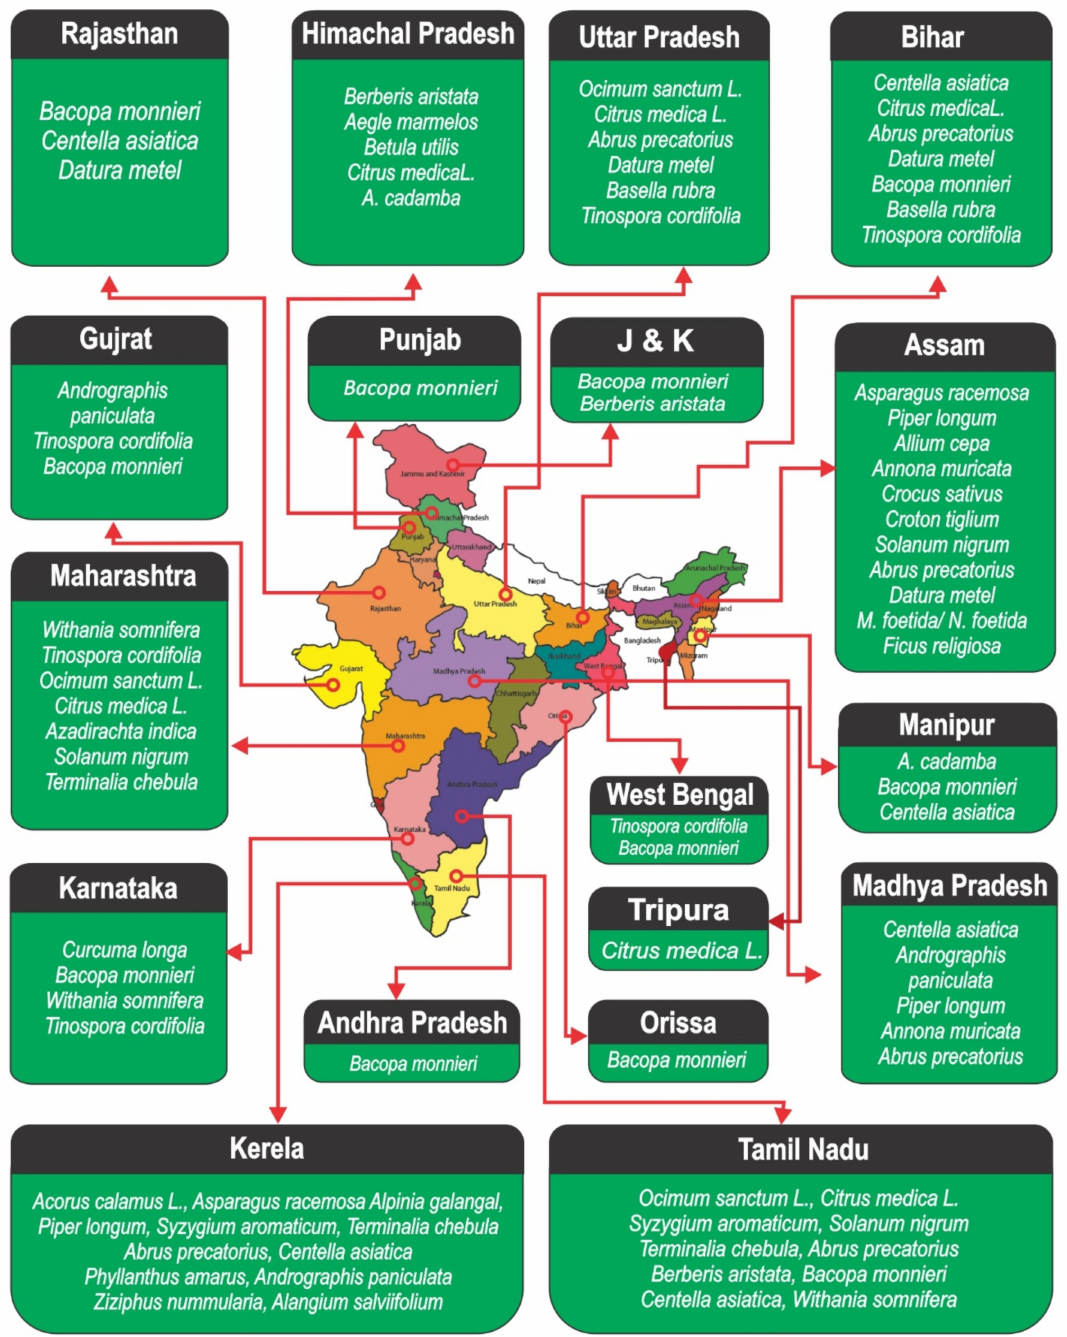
Figure 1. Geographical distribution of some prominent Indian ethnomedicinal